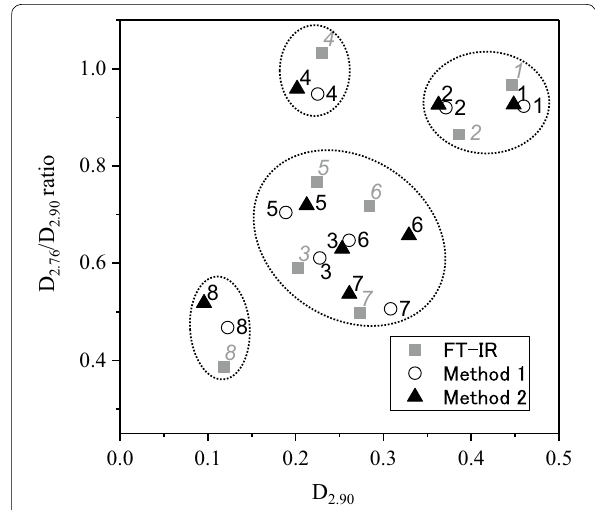
Fig. 11 Relationship between the D 2.90 values and the D 2.75 / D 2.90 ratio. a The D 2.90 values of NIRS3 are corrected using the correc- tion lines shown in Fig. 10d. Labels: 1 Murchison, 2 Murray, = = 3 Y-793321, 4 Jbilet Winselwan, 5 Y 982086, 6 Y 980115, = = = = 7 Y-86720, and 8 B-7904. Surrounded by broken lines are four = = clusters: Highly hydrous chondrites ( 1 and 2 ), Jbilet Winselwan ( 4 ), moderate dehydrated chondrites ( 3 , 5 – 7 ), and severely dehydrated chondrite ( 8 )